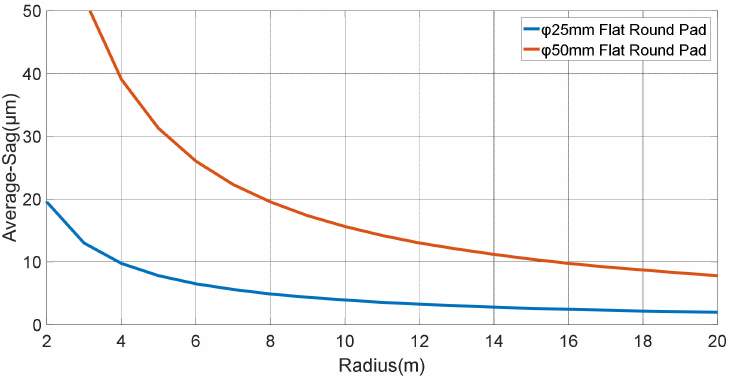
Figure 2. The relationship between the radius of curvature of the measured surface and the average sag for a Ø25 mm and a Ø50 mm